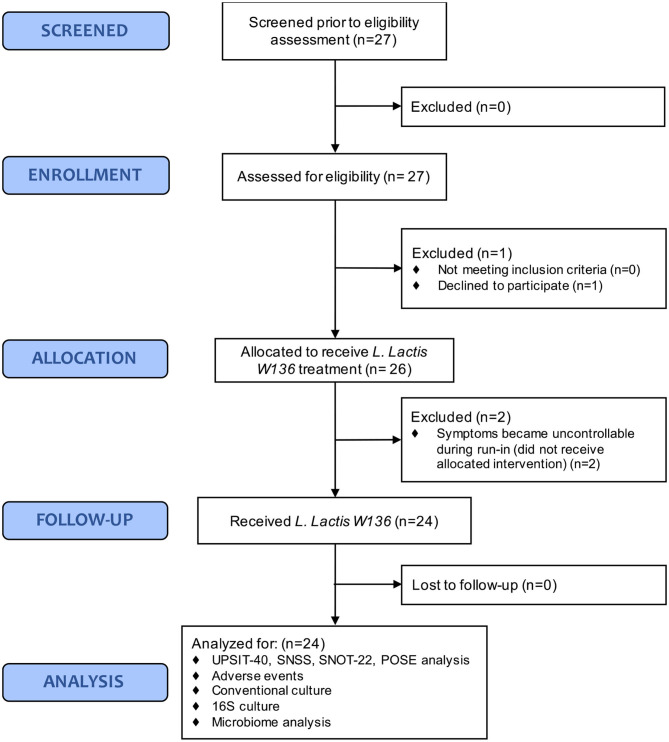
CONSORT statement.